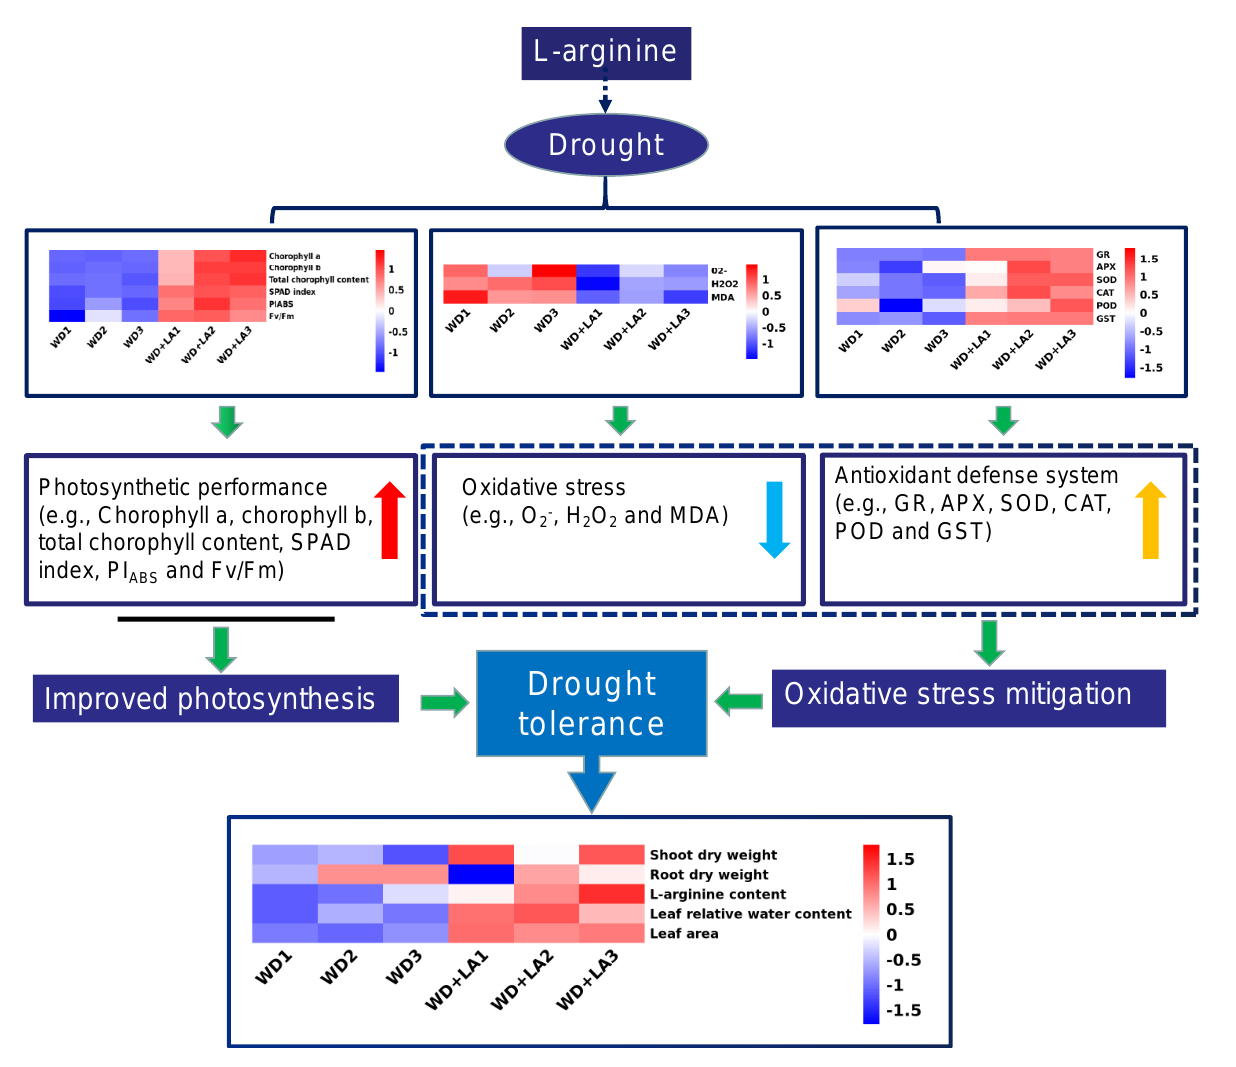
Figure 8. A schematic model describing the regulation of drought stress resistance by L-arginine in maize seedlings. PEG, polyethylene glycol; WD: 20% PEG; WD + LA: 20% PEG + 150 μmol L −1 of L-arginine. The red arrow indicates that the photosynthetic performance was enhanced; the blue arrow indicates that oxidative stress was relieved; the yellow arrow indicates that antioxidant enzyme activity levels increased.